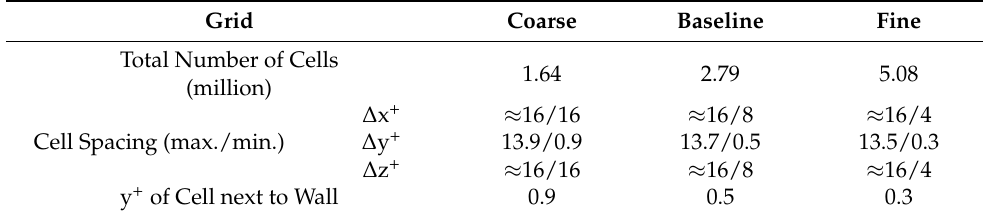
Figure 2. Grids used for LES of flow in the test section without pin fins. Table 2. Summary of grid used for channel without pin fins.